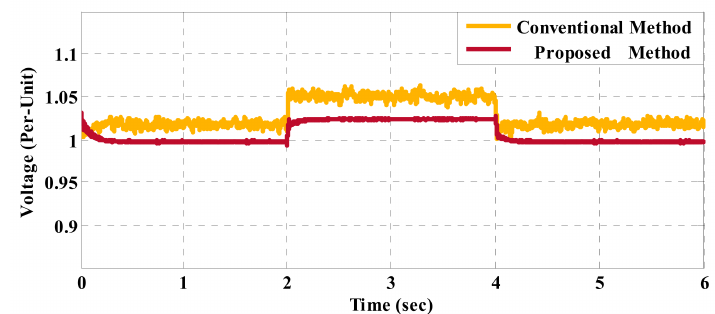
Figure 9. Line voltage comparison of the load-side voltage of DG1.